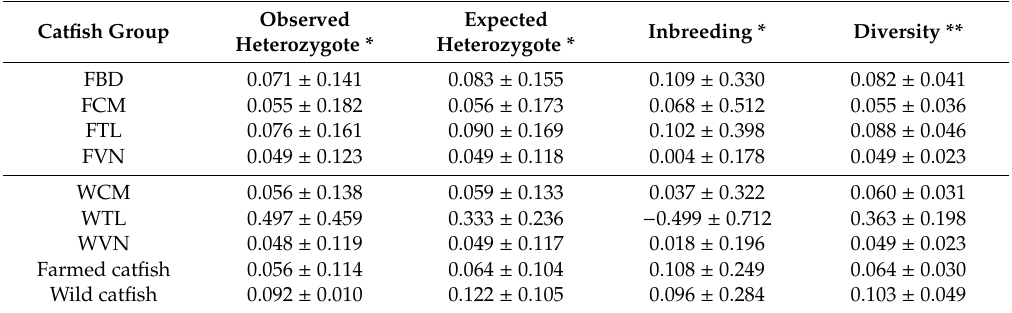
Table 1. Observed ( H o ), expected heterozygosity ( H e ), inbreeding ( F IS ) and diversity in each stock.